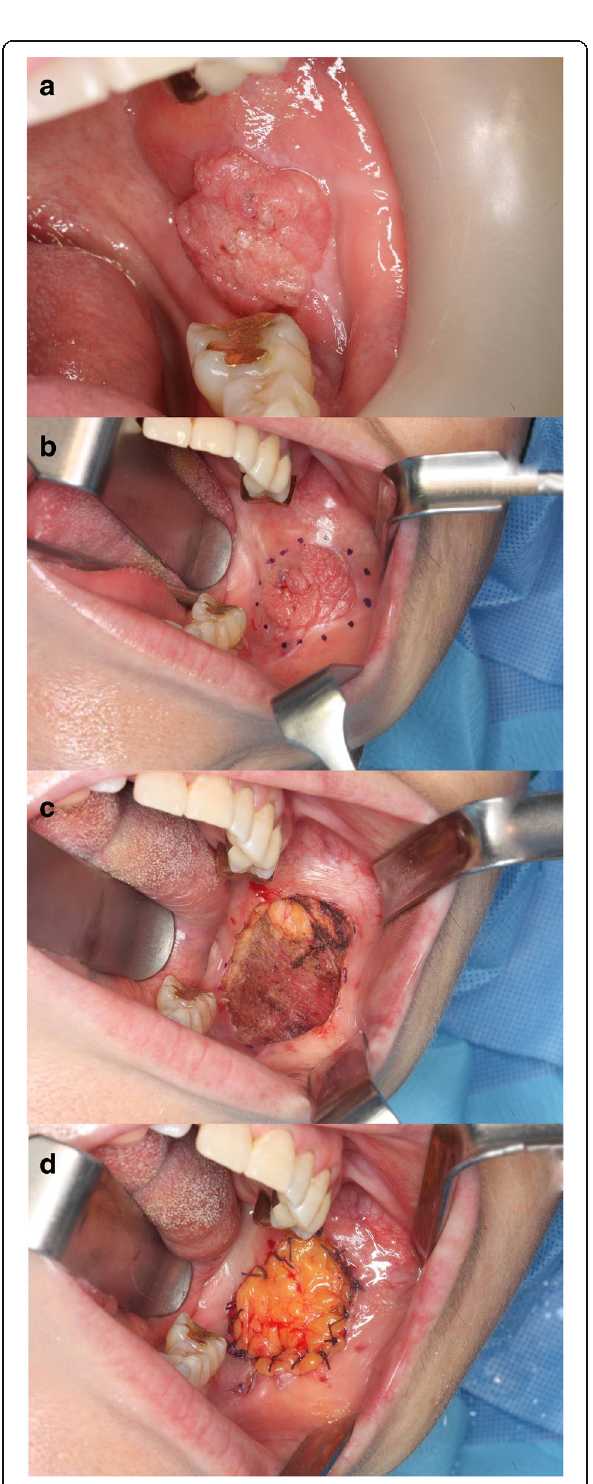
Fig. 1 a Clinical photograph on first visit. b Preoperative lesion. c Lesion was excised. d The immediate post-operative result